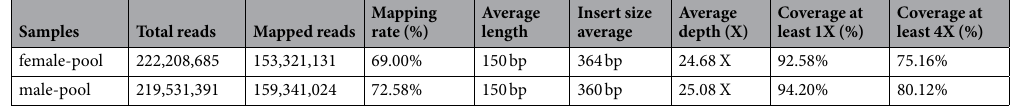
Table 1. Summary of sequence data from the pooled libraries.